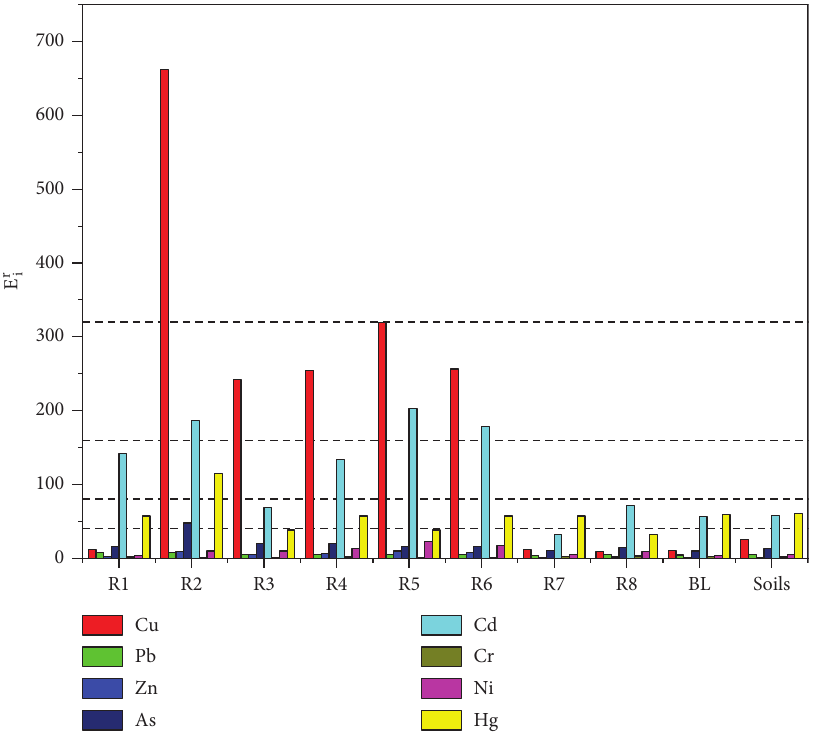
Figure 5: The potential ecological risk index of sediments and soil. Table 5: Potential ecological RI for heavy metals in sediments and